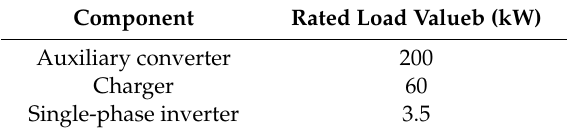
Table 4. Auxiliary power supply system rated load value.